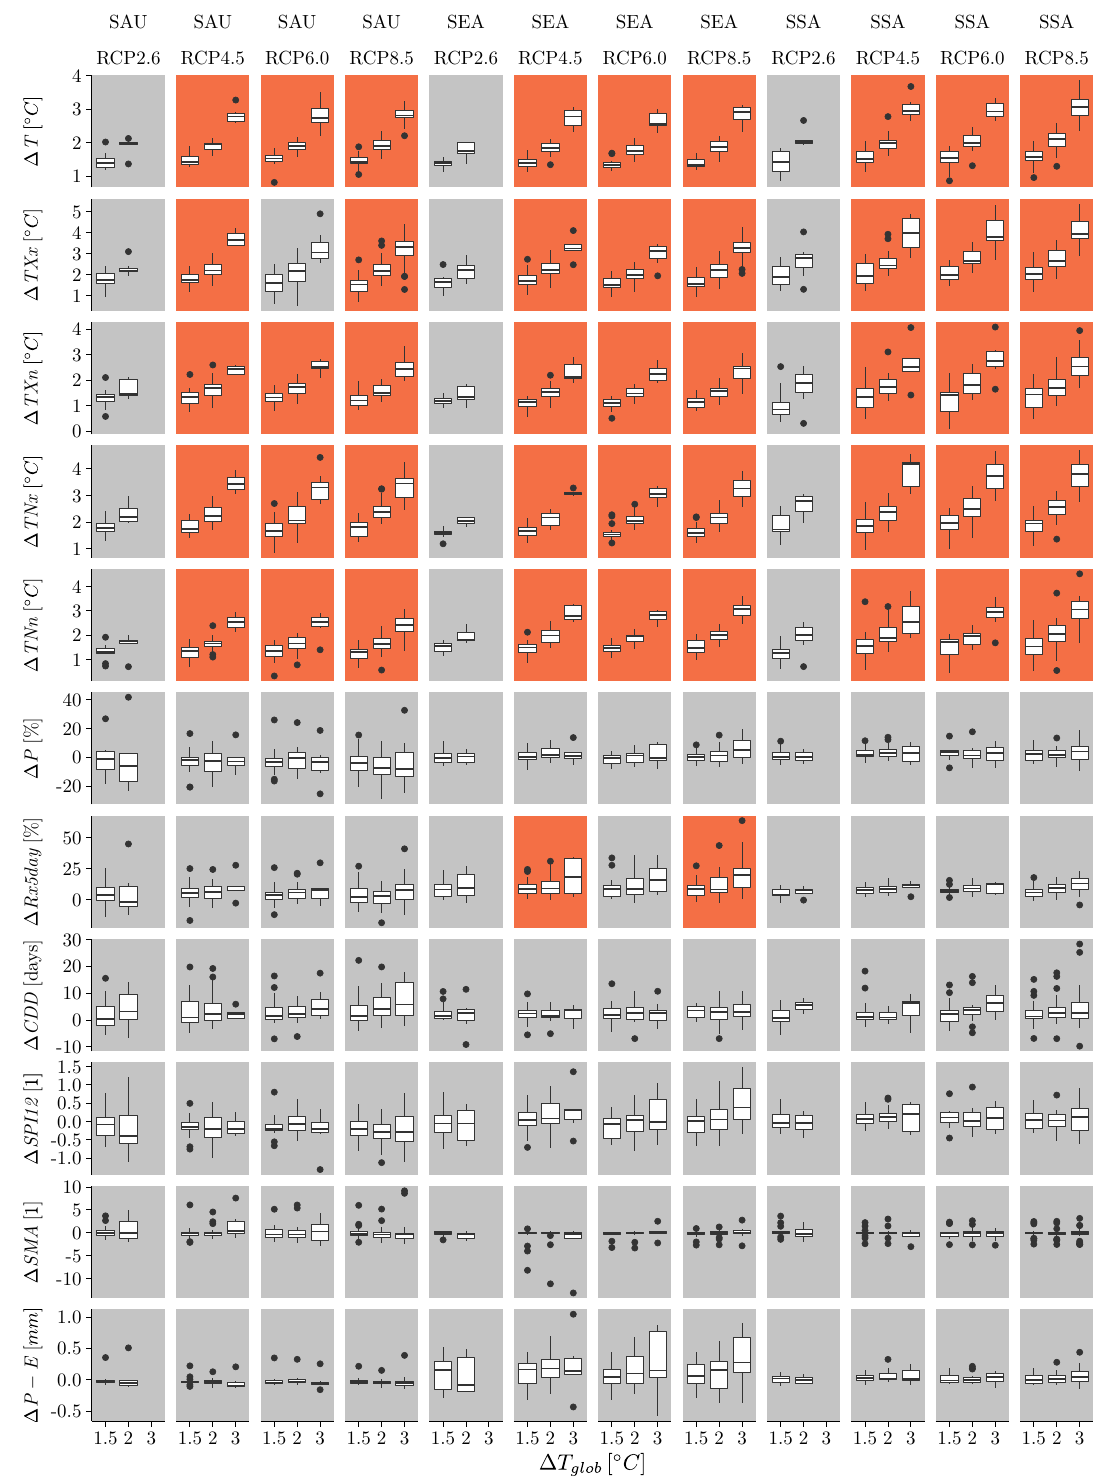
N o significant difference in between the distributions of for and S ignificant difference in between the distributions of for and Figure A5. Like Fig. A1 but for SREX regions SAU, SEA, and SSA.